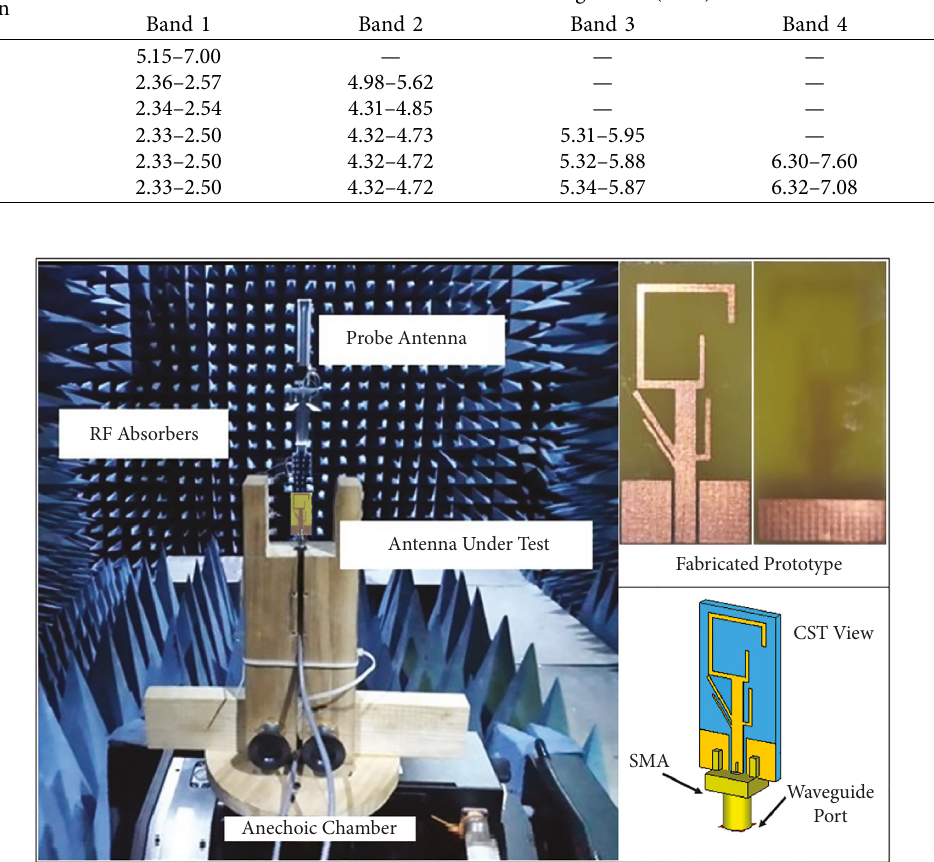
Figure 4: Antenna prototype in the measurement phase.